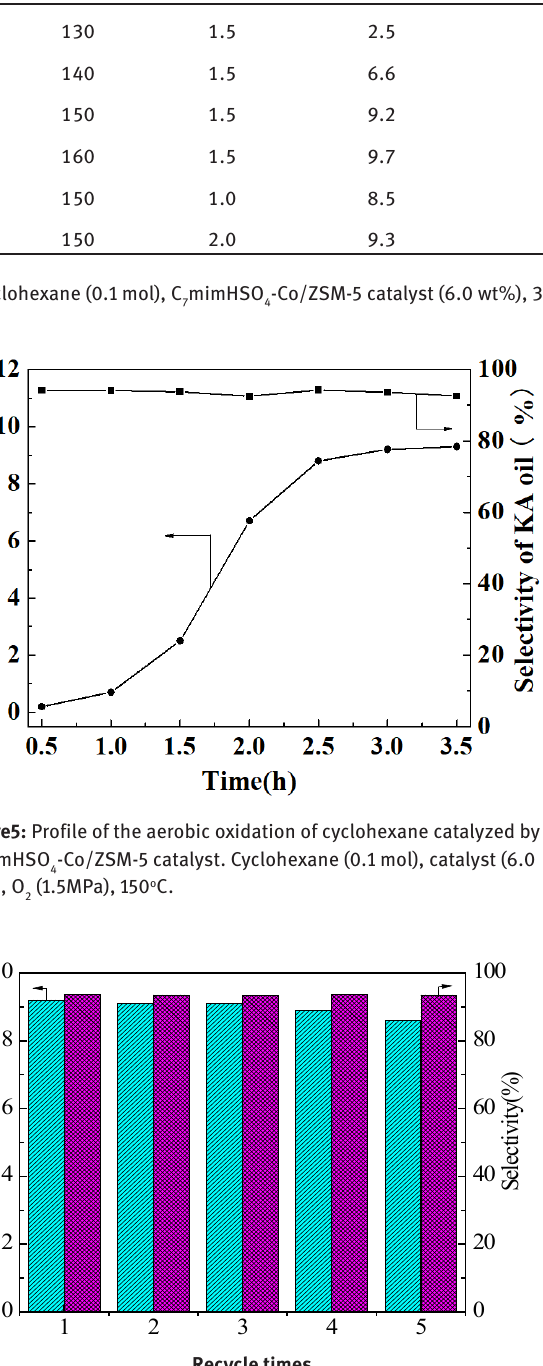
Figure 6: Stability and reusability of C in the aerobic oxidation of cyclohexane. Cyclohexane (0.1 mol), catalyst (6.0 wt%), O